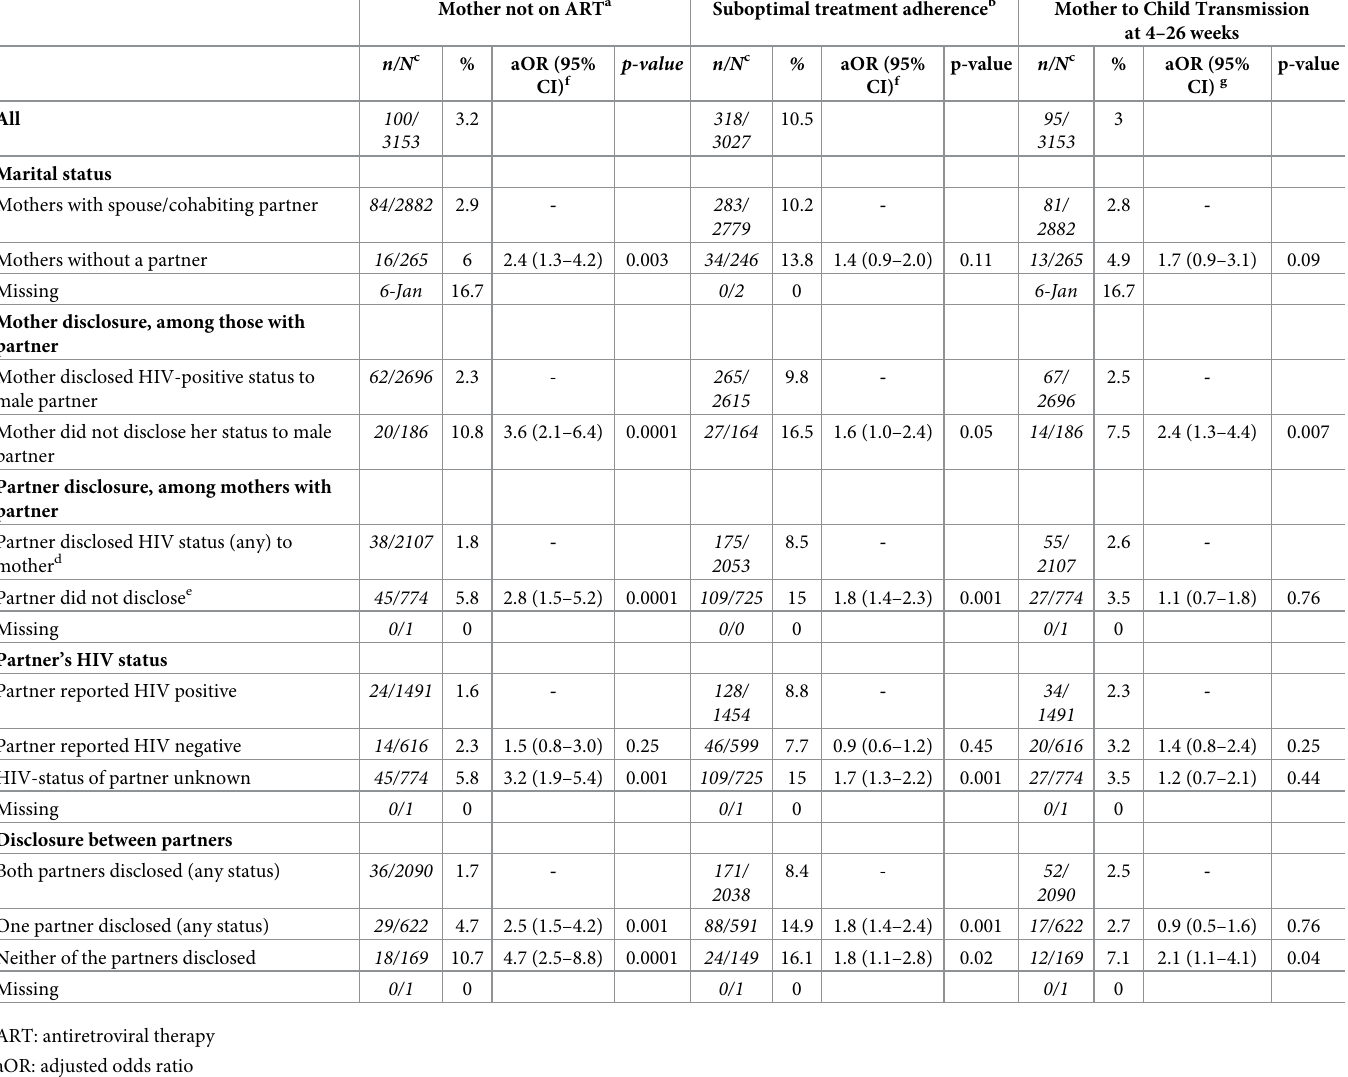
Table 2. Partner disclosure patterns and associations with treatment and MTCT